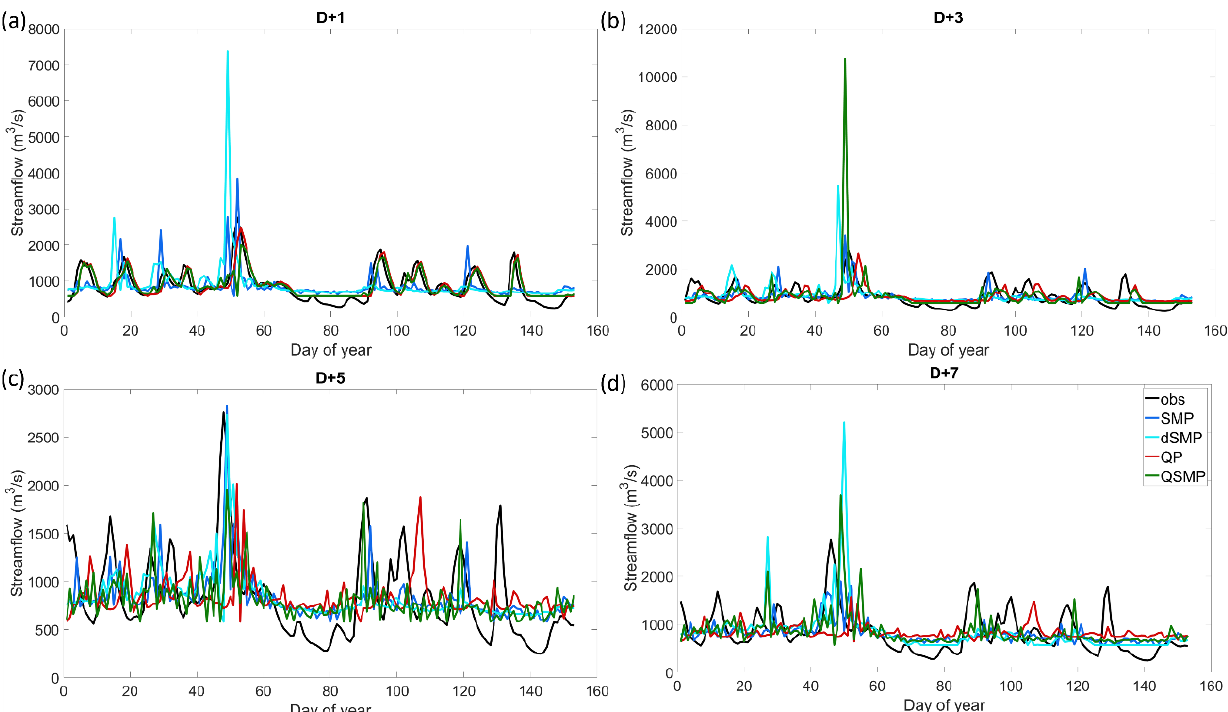
Figure 10. Hydrographs for the Susquehanna watershed for summer 2009 (validation period) ( a ) 1, ( b ) 3, ( c ) 5 and ( d ) 7 days in advance.